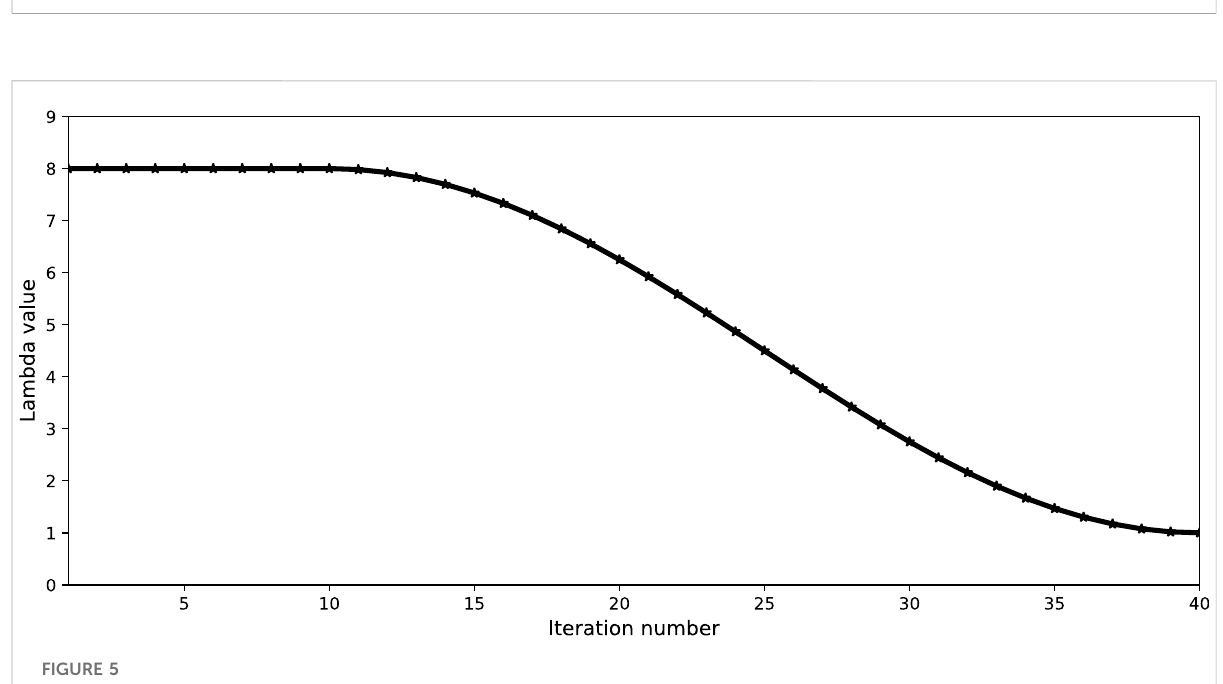
FIGURE 5 The relationship between the weight factor lambda and iterations. λ is set to 8.0 in the fi rst 10 iterations, and then gradually reduces to 1.0 according to the change of cosine function in subsequent iterations.